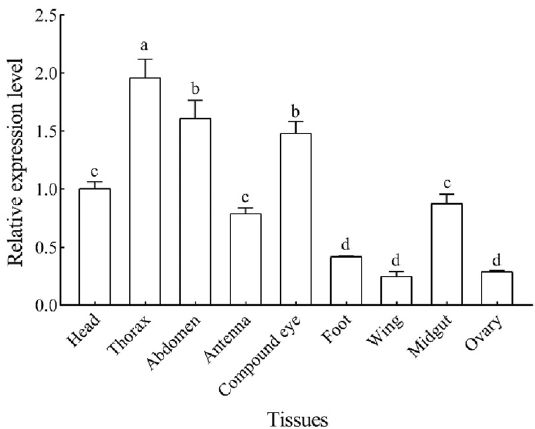
Figure 3. Relative expression levels of Hap38 MAPK in different adult tissues of H. armigera . The expression levels of genes in the head were normalized. Data in the figure are expressed as mean ± SE. Different letters above bars indicates significant difference ( P < 0.05, ANOVA).